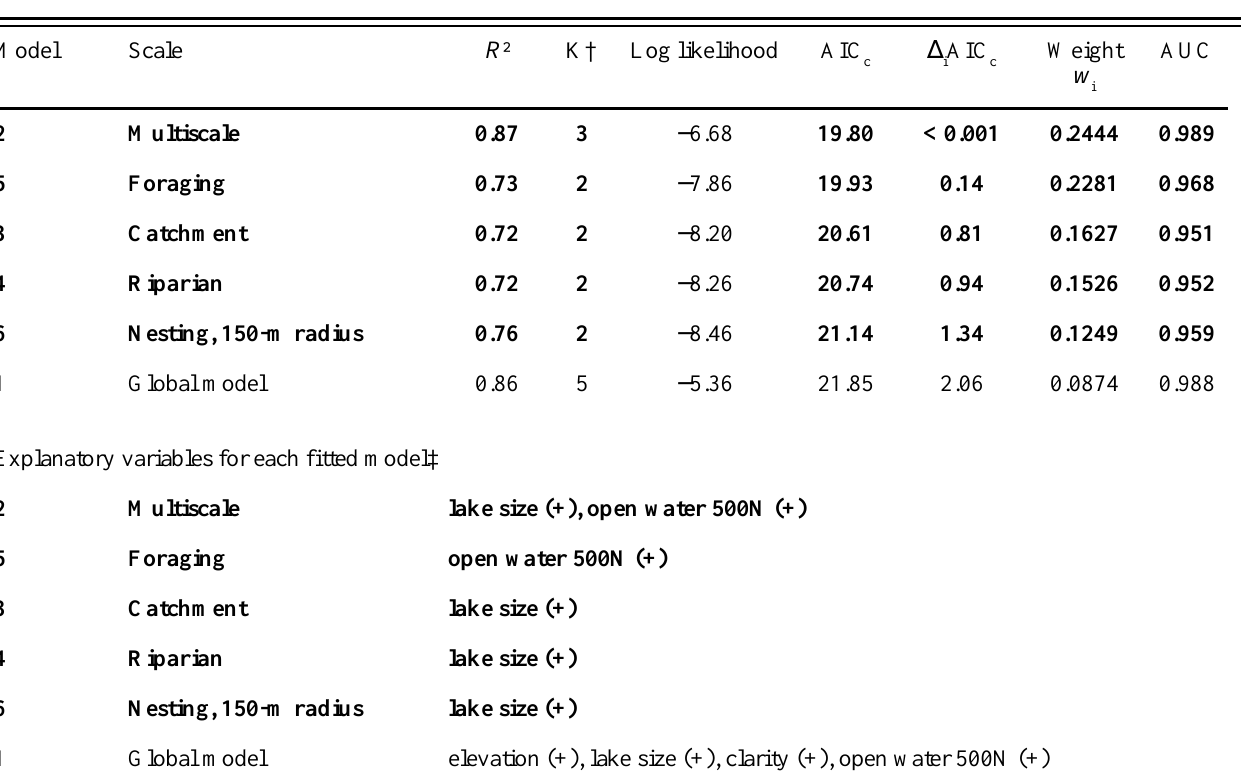
£ 2, are indicated in bold. c